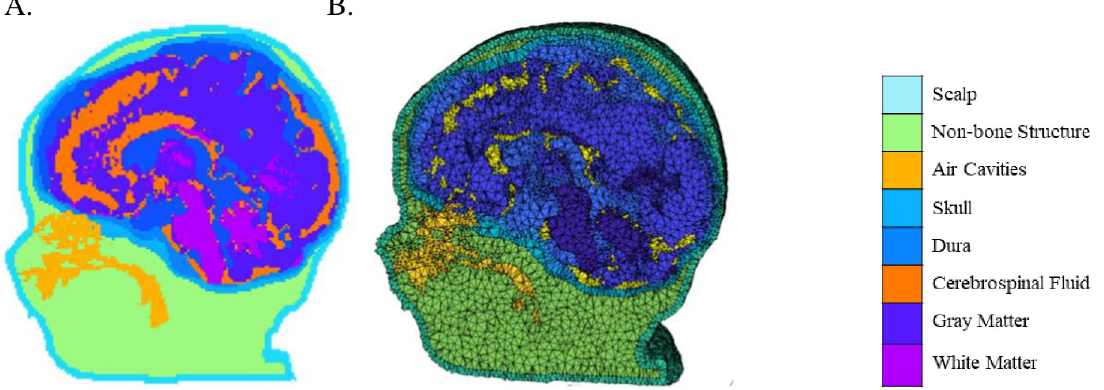
Fig 1. Segmented head MRI volumes. The examples were taken from the same 3-month-old infant MRI. A. The segmented head model. Aqua is the scalp, green is the non-bone structure (muscle, sinew, fat), gold is the nasal and mouth air cavities, turquoise is the skull, light blue is the dura, orange is the cerebrospinal fluid, dark blue is the gray matter, and purple is the white matter. B. The segmented head model with dense finite element (FE) mesh.